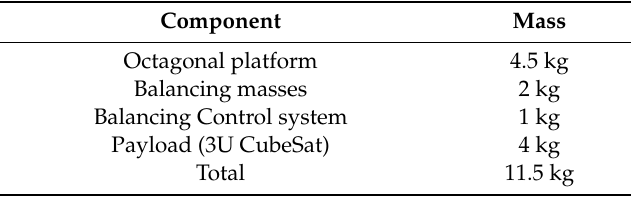
Table 2. Mass budget of the automatic balancing system.